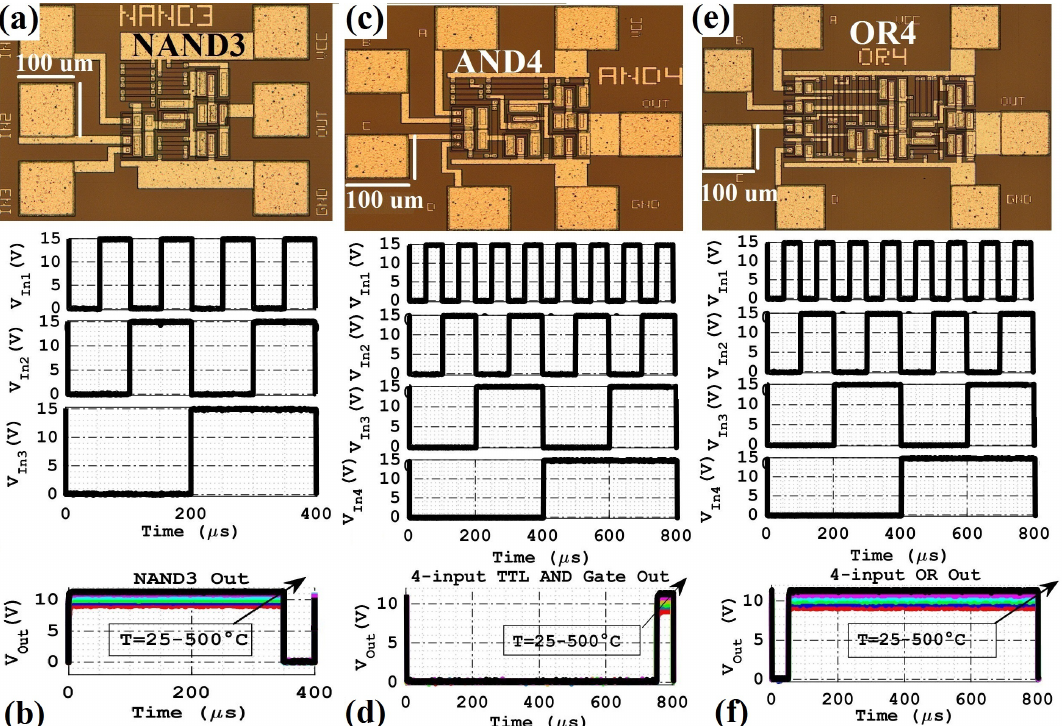
Figure 13. SiC TTL gates micro-photograph with measured transient-response in the range of 25 to 500 ○ C by applying f in 1 = 10 kHz f in 2 = 5 kHz and f in 3 = 2.5 kHz and f in 4 = 1.25 kHz, with V IH = 15 V and V IL = 0 V ( a ) NAND3 micro-photograph ( b ) NAND3 measured transient-response ( c ) AND4 micro-photograph ( d ) AND4 measured transient-response ( e ) OR4 micro-photograph ( f ) OR4 measured transient-response.